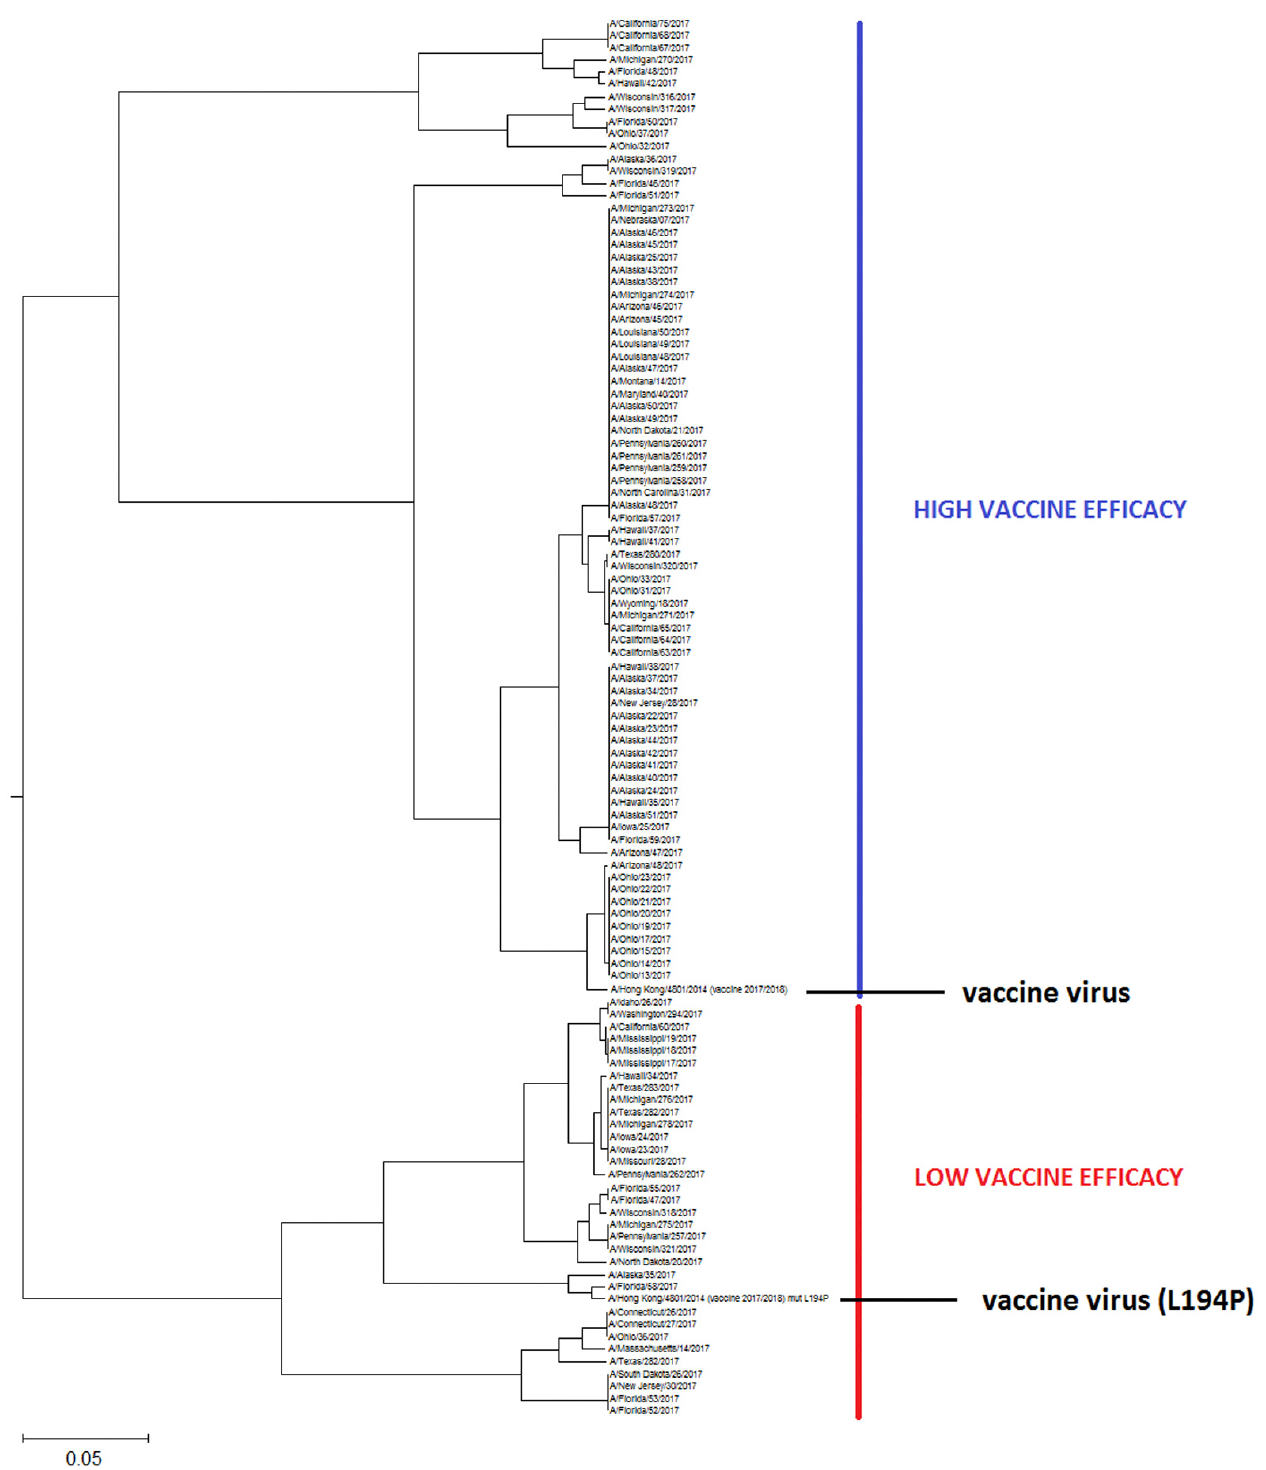
Figure 2. The schematic presentation of the ISM-based phylogenetic tree of the HA1 from human H3N2 influenza viruses collected in US from July to September 2017. This tree in high resolution is given in Figure S2.